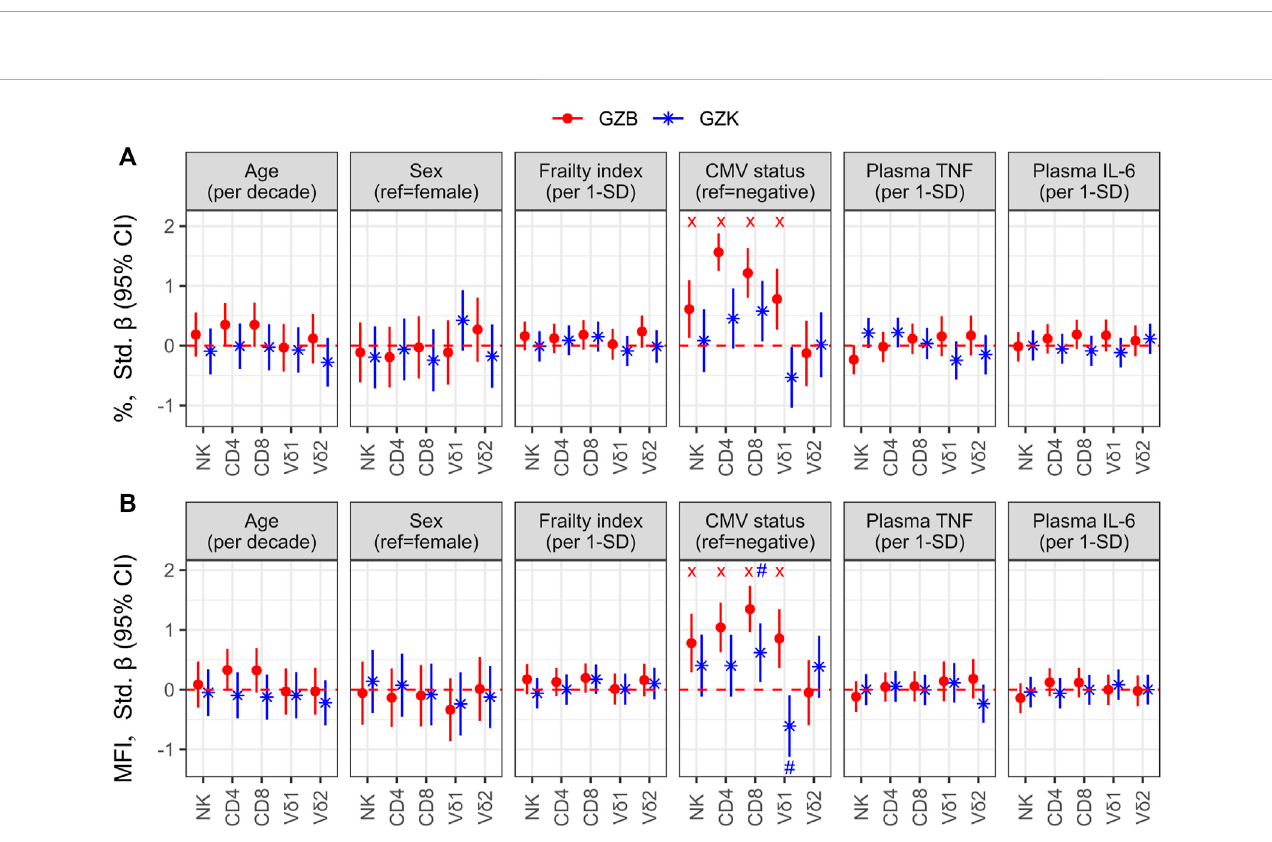
FIGURE 3 FactorsassociatedwithGZBandGZKexpressioninolderadults. (A) ThelogfrequencyofGZBorGZK-expressingcellsand (B) thelogmean fl uorescence intensity (MFI)ofeachpopulation wasregressed onage, sex,frailtyindex, CMVserostatus, andplasmaTNFand IL-6, whileadjusting forsiteofenrollment.For sexandCMVstatus,contrastsaremalesvs.femalesandpositivevs.negativeparticipants,respectively.Forallothers,coef fi cientsarerelativetothemagnitude ofincrease shown inbrackets.Nooverlap ofthe95% CI withthereddotted line indicatesthat theassociation issigni fi cantatthenominallevel,while the ‘ x ’ and ‘ # ’ indicate that the respective associations for GZB or GZK maintained signi fi cance at an FDR adjusted p < .05.